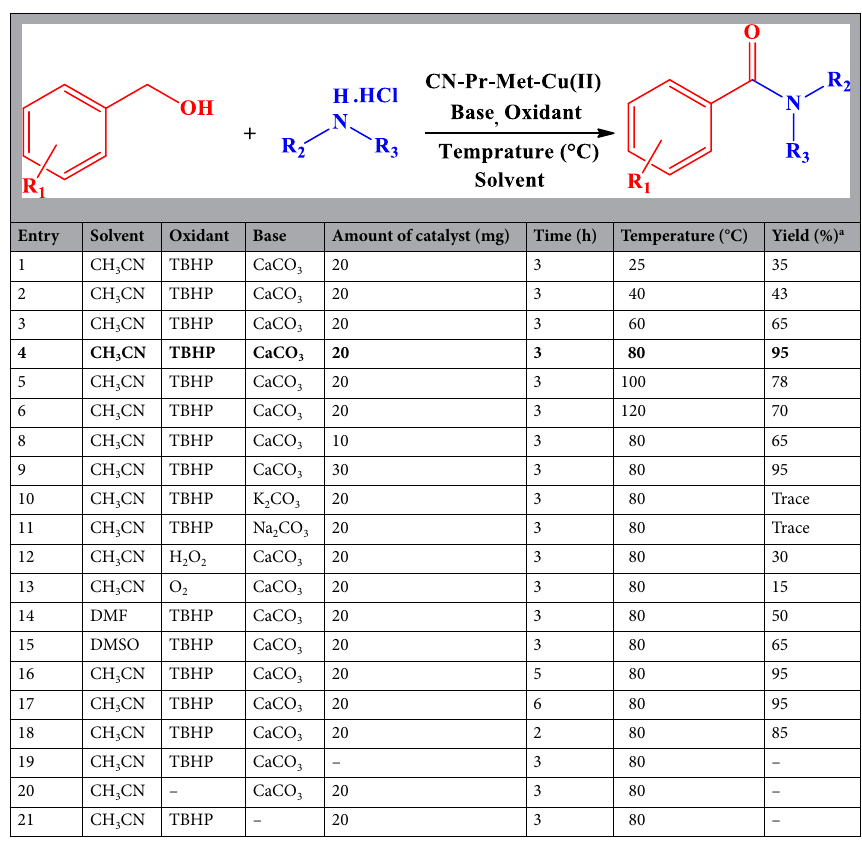
Table 1. Optimization of the reaction condition for the one-pot direct oxidative amidation. Reaction condition: benzylamine hydrochloride (1.0 mmol), benzyl alcohol (1.5 mmol), catalyst (CN–Pr–Met–Cu(II)), solvent (3.0 mL), base (1.1 Equiv), oxidant (70 wt % in H 2 O, 4 Equiv), under N 2 atmosphere. a Isolated